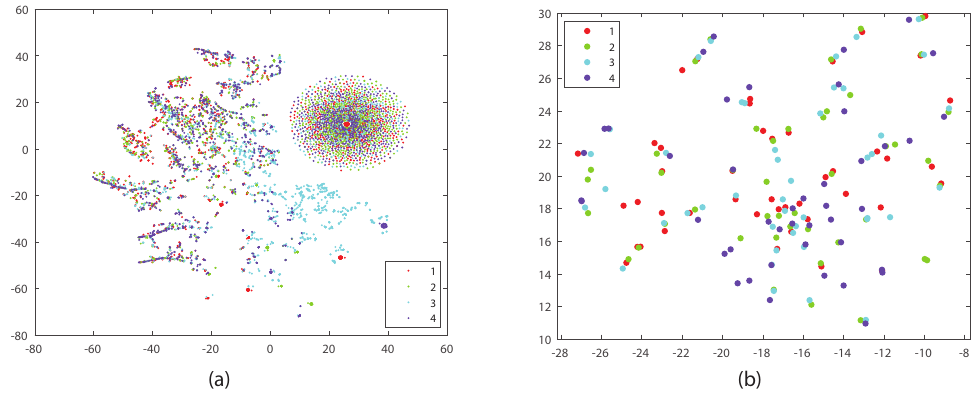
Figure 4. ( a ) concatenated original data; ( b ) our approach using t-SNE on KERTAS dataset (based on four